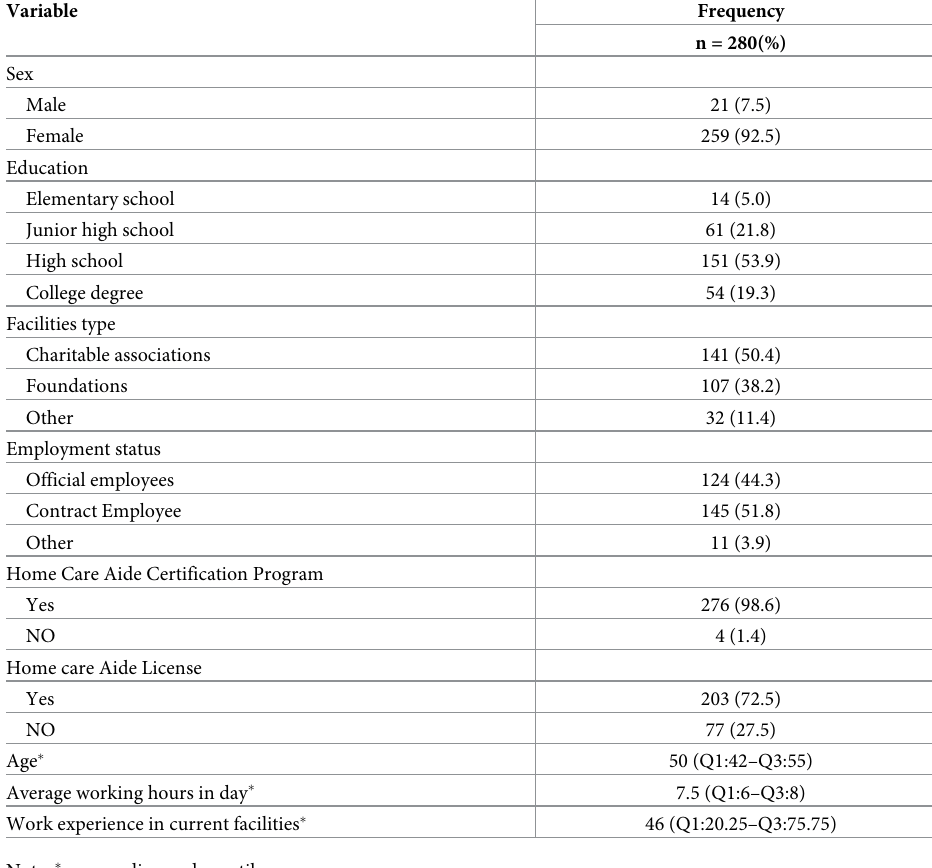
Table 1. The characteristics of the home care